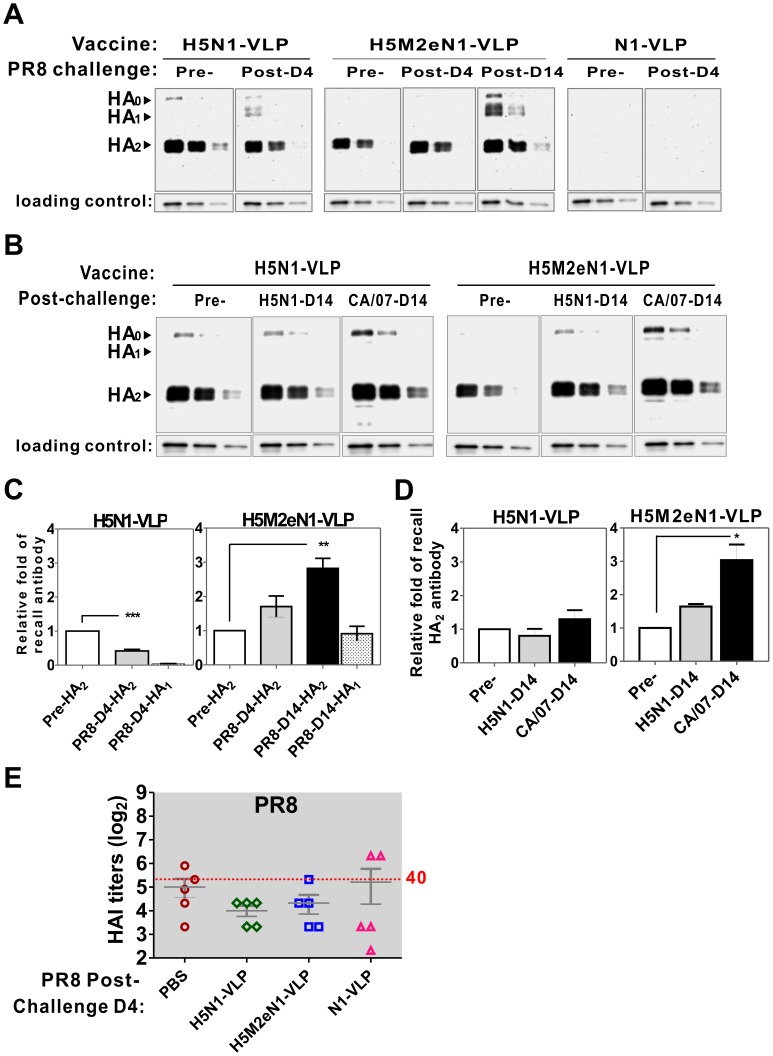
Recall antibody response induced by VLP vaccination to influenza.(A) Western blot analysis of VLP-induced humoral immunity against PR8 HA. The PR8 HA0 (11684-V08H, Sino Biological Inc.; expressed by baculovirus system) was treated with TPCK-trypsin (5 µg/mL) at 37°C for 15 min to induce cleavage into HA1 and HA2. The cleaved PR8 HA was admixed with purified H3N2-VLP (providing annexin A2 as loading control), serially diluted in two folds and quantified by western blot analysis. The antibody against the annexin A2 (ab41803, Abcam) in H3N2-VLP was used to normalize the loading amount of protein samples and transfer efficiency of western blotting. Mice vaccinated with various VLPs were bled before (Pre-), 4 days (Post-D4) or 14 days (Post-D14) after challenge as indicated. The antisera (500-fold dilution used in this assay) were analyzed by western blotting. HA0, HA1, and HA2 are labeled on the left. (B) Comparative analysis of cross-reactive anti-HA2 antibody elicited by VLP vaccination before challenge or recalled after homologous and heterologous viral challenges. VLP vaccines and strains of challenge virus are as indicated. (C), (D) The relative folds of antibody response specific to PR8 HA1 or HA2 in panel A and B were quantified and summarized correspondingly. Comparing the relative level of HA2 antibody before and after viral challenge, asterisk indicates statistic significance as used in Figure 1. (E) The HAI titers in vaccinated mice 4 days after PR8 infection were determined by standard methods. Scatter plot with mean values of the same group; bars, SEM. Type of VLP vaccine or PBS control is indicated.